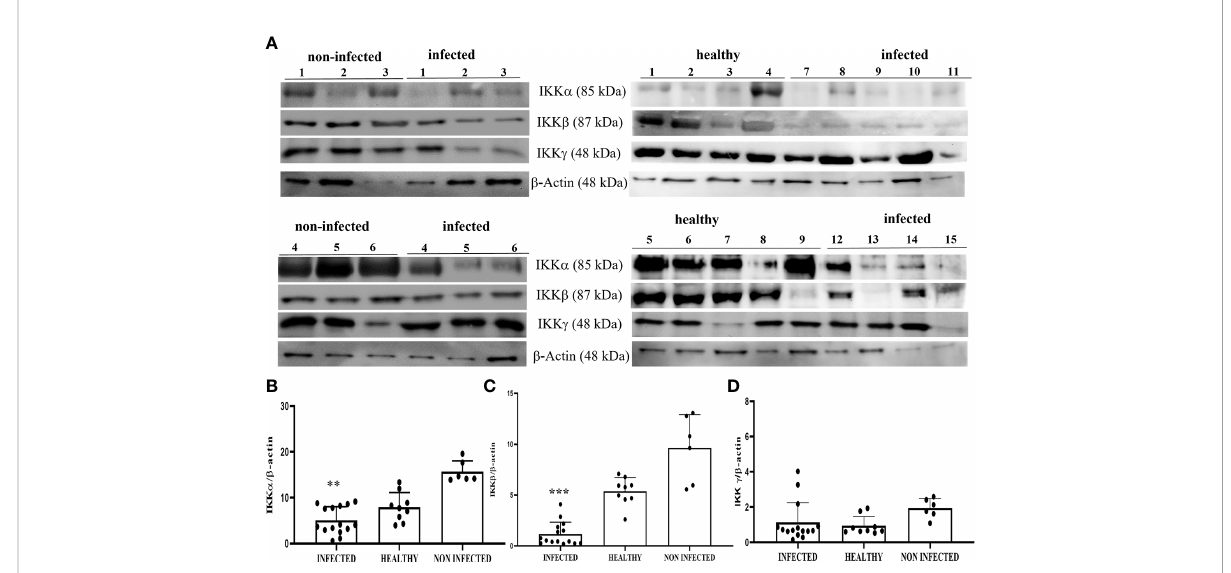
FIGURE 10 (A) Western blot analysis of IKK a , IKK b , and IKK g proteins in infected, non-infected, and healthy bladder samples. (B, C) Densitometric analysis of IKK a and IKK b protein levels relative to b -actin protein levels showed a statistically signi fi cant difference (**p ≤ 0.01 and ***p ≤ 0.001, respectively) of infected compared with both non-infected and healthy bladder tissue samples. (D) Densitometric analysis of IKK g protein relative to b -actin protein levels: no signi fi cant variation was observed. Plots present values found in each sample performed in triplicate.